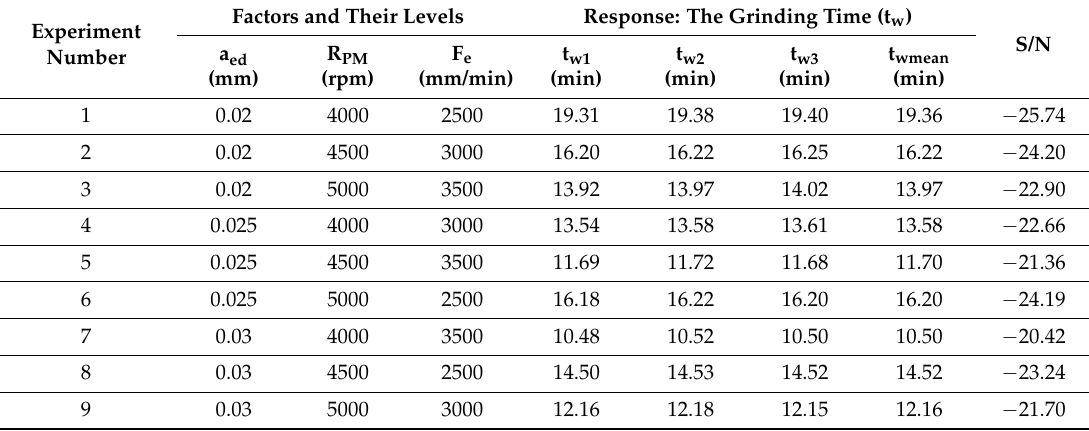
Table 4. Experimental results of L9 (3 3 ) for grinding time and their corresponding S/N